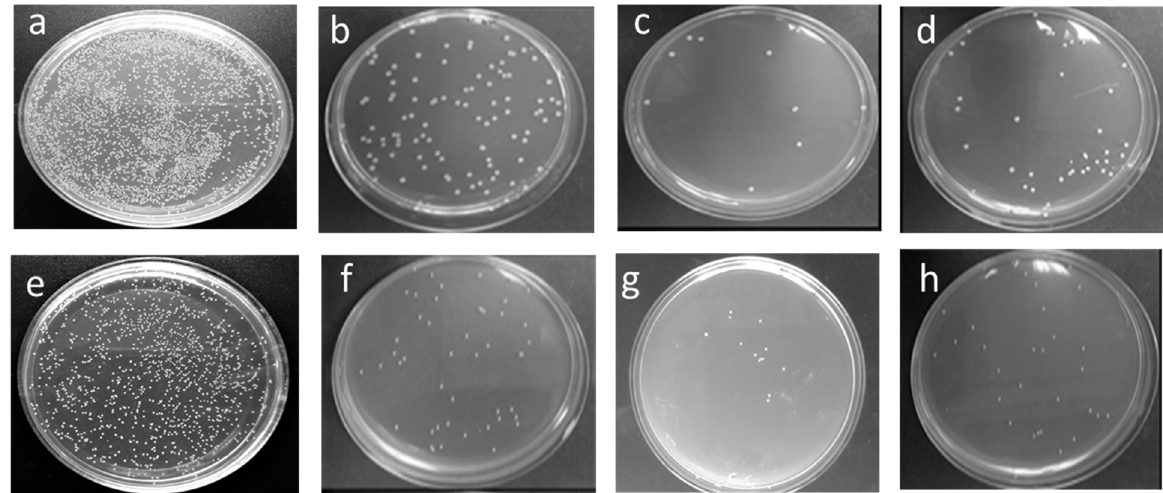
Figure 6. Bacterial reduction disk images after 24 h contact time for ( a ) untreated fabric, ( b ) NanoZnO-1, ( c ) NanoZnO-2, and ( d ) NanoZnO-3 for S. aureus and ( e ) untreated fabric, ( f ) NanoZnO-1, ( g ) NanoZnO-2, and ( h ) NanoZnO-3 for E.coli.